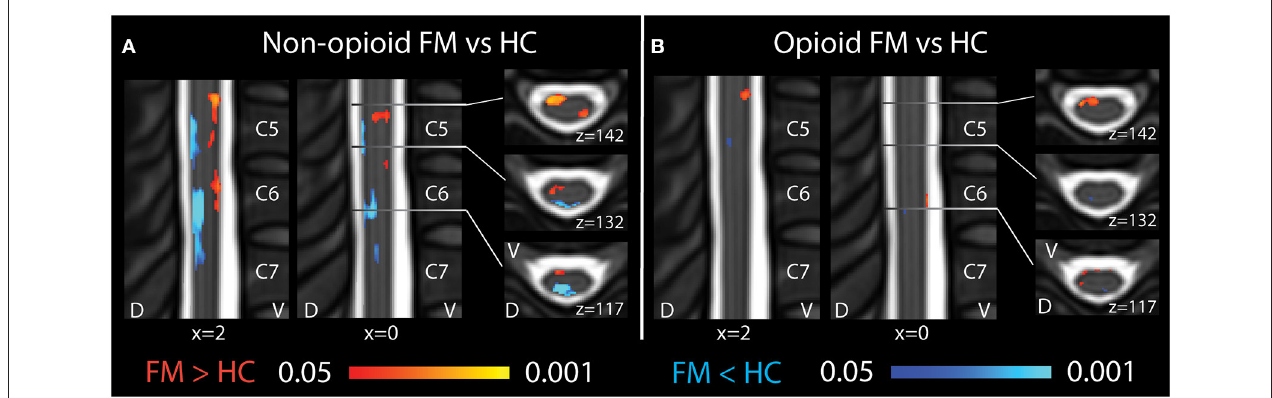
FIGURE 2 | Spinal cord regional mean ALFF differences among patients taking and not taking opioids vs. healthy controls. (A) Compared to healthy controls, fibromyalgia patients who were not taking opioids (non-opioid FM) showed several spinal cord regions of ventral increases and dorsal decreases in Mean ALFF. Images reused and modified with permission from Martucci et al. (16). (B) Compared to healthy controls, opioid fibromyalgia patients (opioid FM) showed few regions of altered Mean ALFF. Red shading indicates regions of greater Mean ALFF and blue shading indicates regions of lesser Mean ALFF in patient groups vs. healthy controls. Sagittal images are indicated with “x” coordinate locations and axial images are indicated with “z” coordinate locations based on the PAM50 template (23). D, dorsal; FM, fibromyalgia; HC, healthy controls; L, left; R, right; V, ventral. P -values are uncorrected < 0.05.